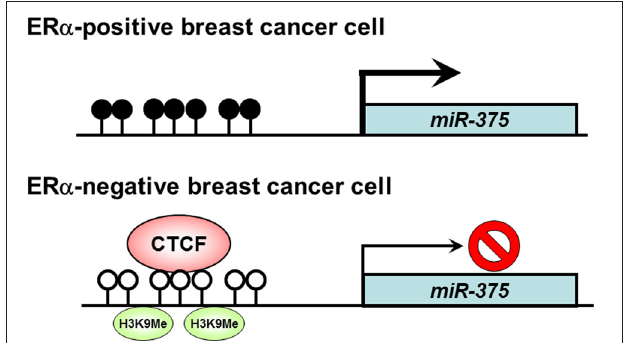
FIGURE 2 | Role of CTCF in the regulation of miR-375 expression in breast cancer cells. In ER α -positive breast cancer cells, DNA hypermethylation is observed in the CpG island of the miR-375 gene, and miR-375 expression is activated. On the other hand, in ER α -negative breast cancer cells, DNA hypomethylation and histone H3 K9 dimethylation are observed, resulting in silencing of miR-375 expression by binding of CTCF in the CpG island. Open circle, unmethylated DNA; filled circle, methylated DNA; H3K9Me, histone H3 K9